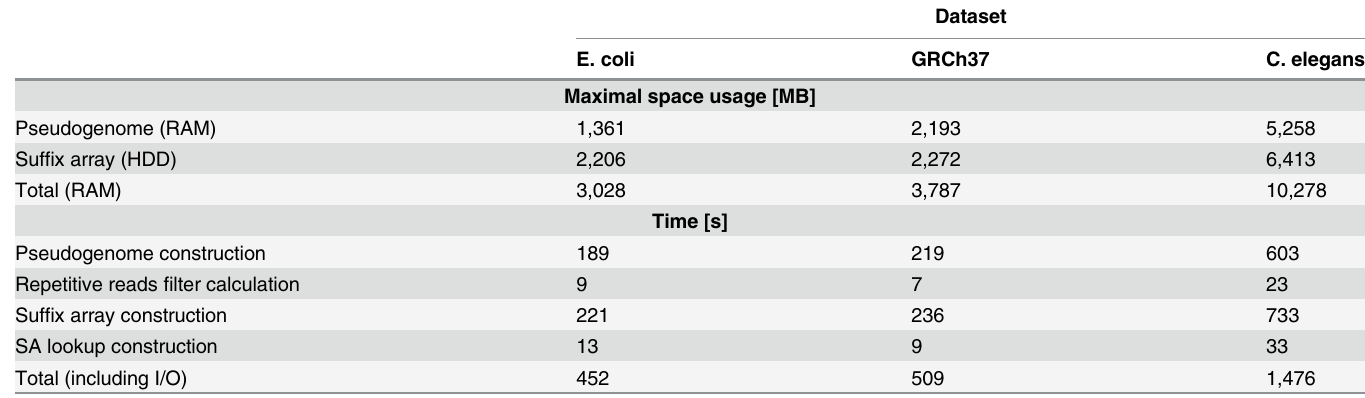
Table 5. Times and maximum memory usages for the PgSA index construction